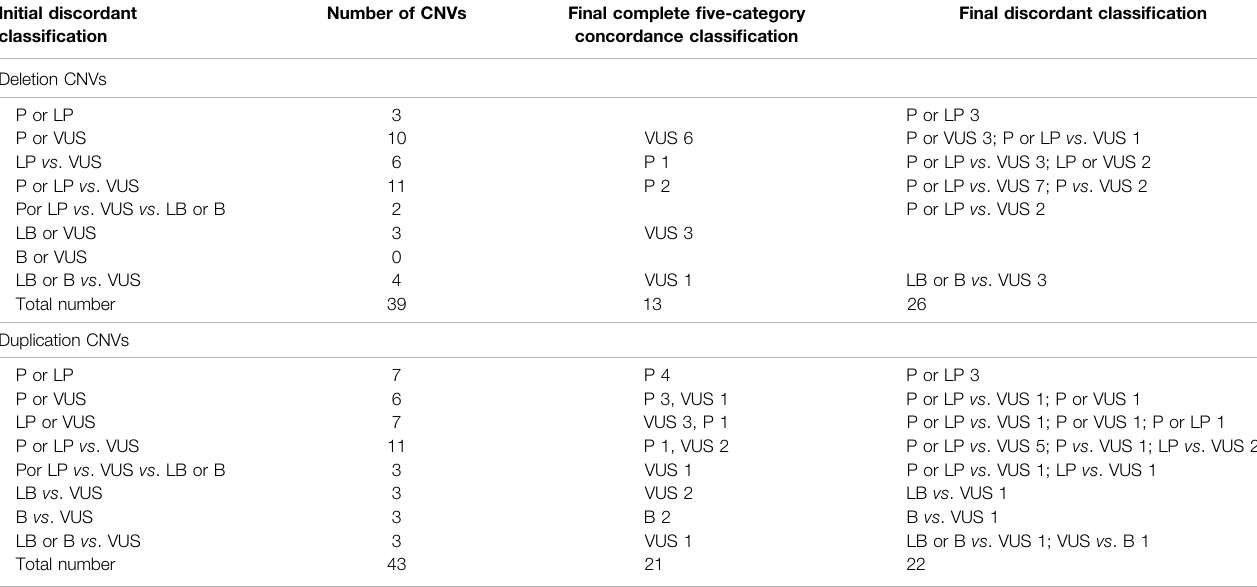
TABLE 2 | Final classi fi cations of discordant